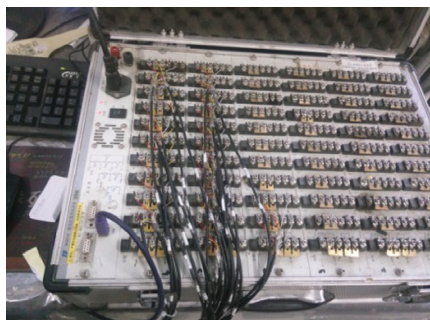
Figure 6: Static strain collection